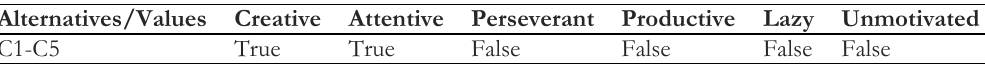
Table 19. The matrix of criteria for the second sensitive